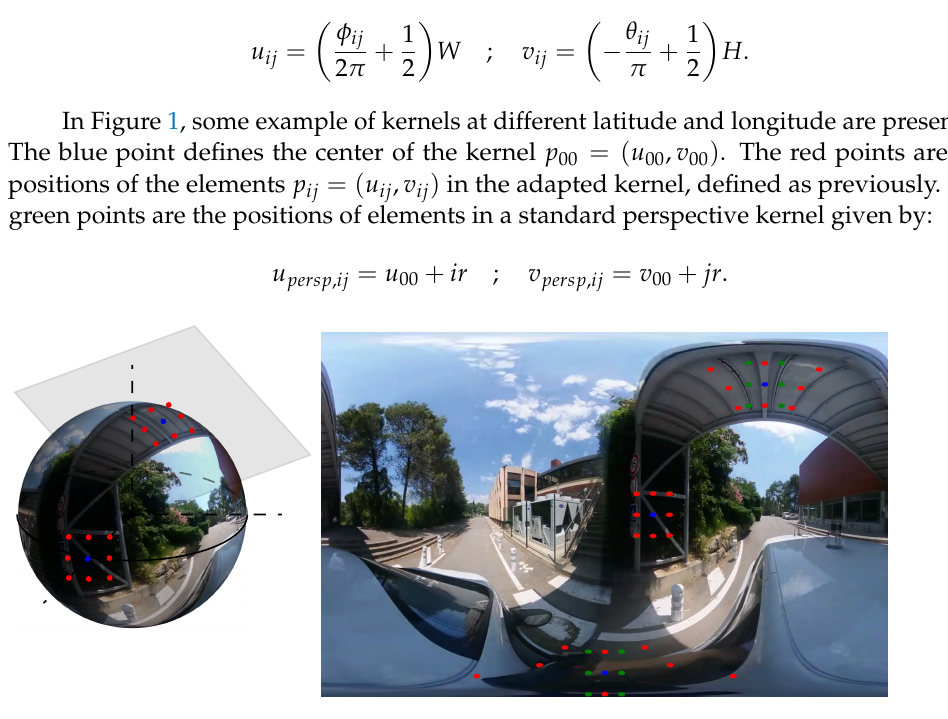
Figure 1. The equirectangular image presents significant distortions in the polar regions. Convolution kernel shapes are modified according to their latitude. Blue: kernel center; Green: perspective kernel; Red: adapted equirectangular